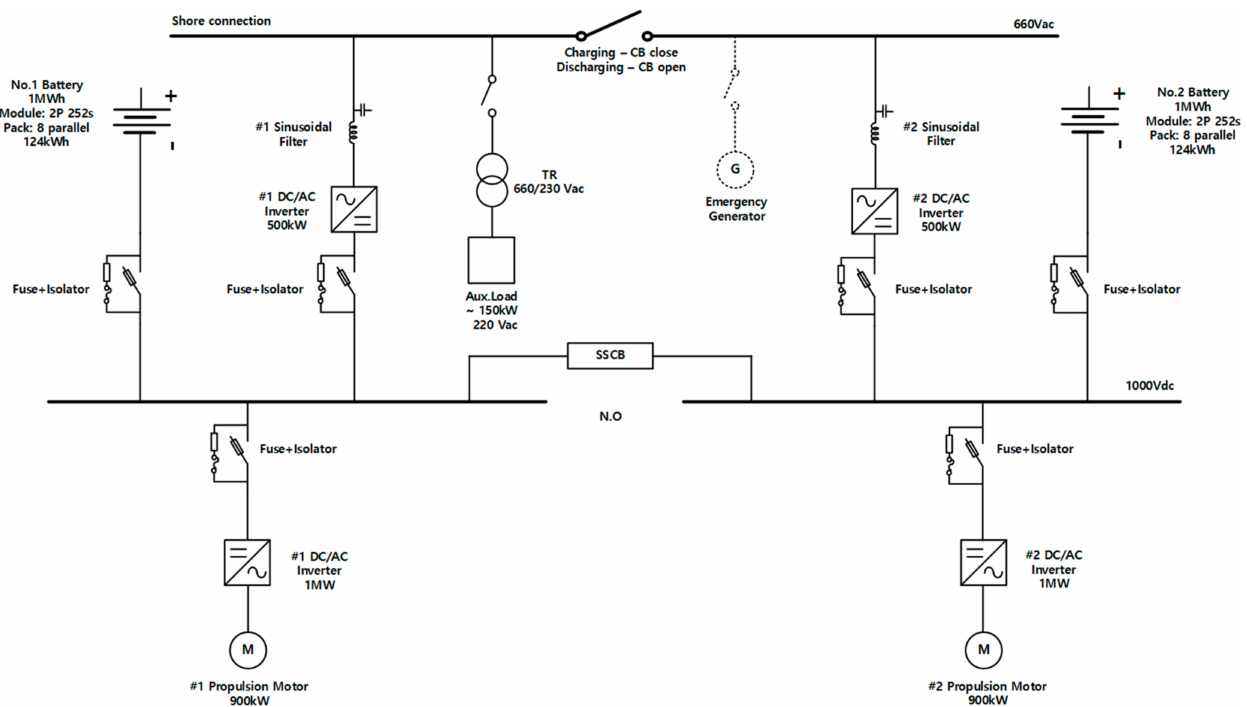
Figure 14. Schematic diagram after removing the battery side DC/DC